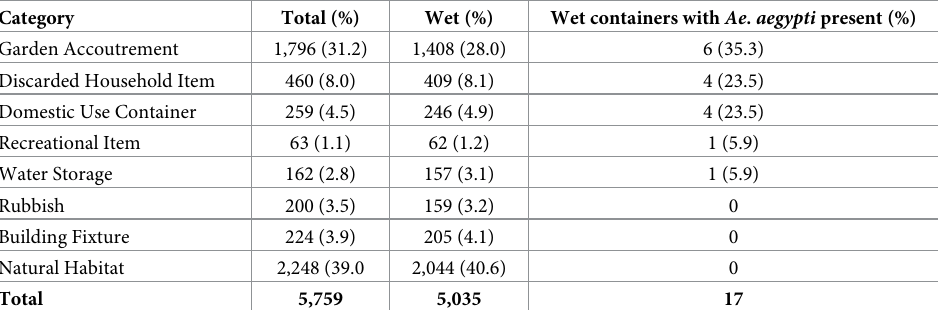
Table 1. Prevalence of water bearing containers and number with Aedes aegypti juvenile stages in Gin Gin, Aus- tralia. Container data collected during town-wide surveillance activities summer 2011–12 and classified by the Barker-Hudson method